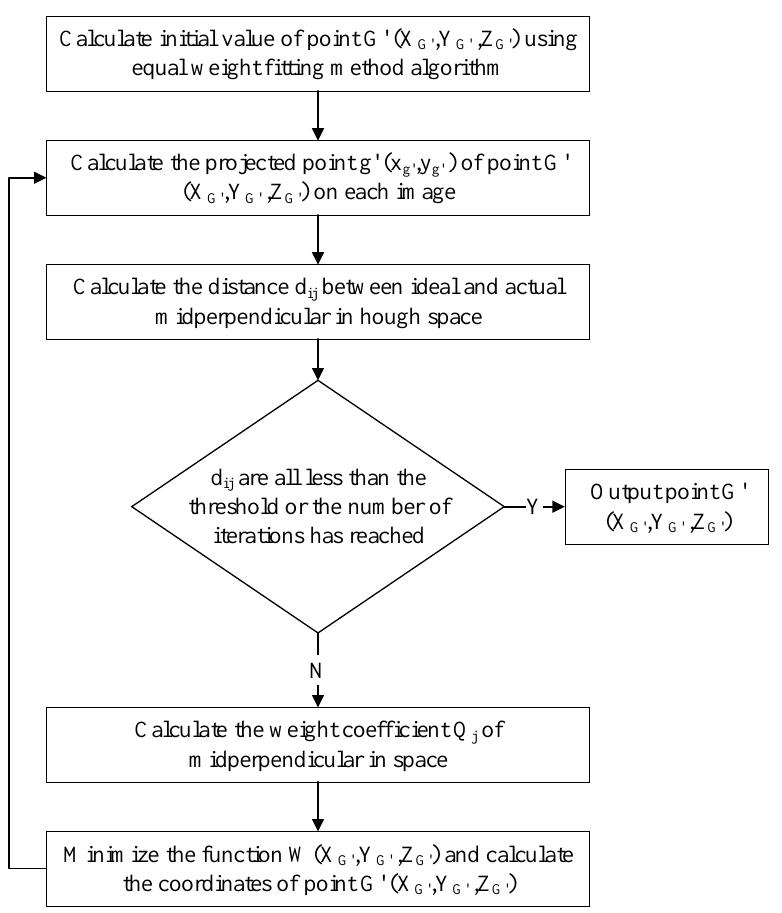
Figure 3. Flowchart of